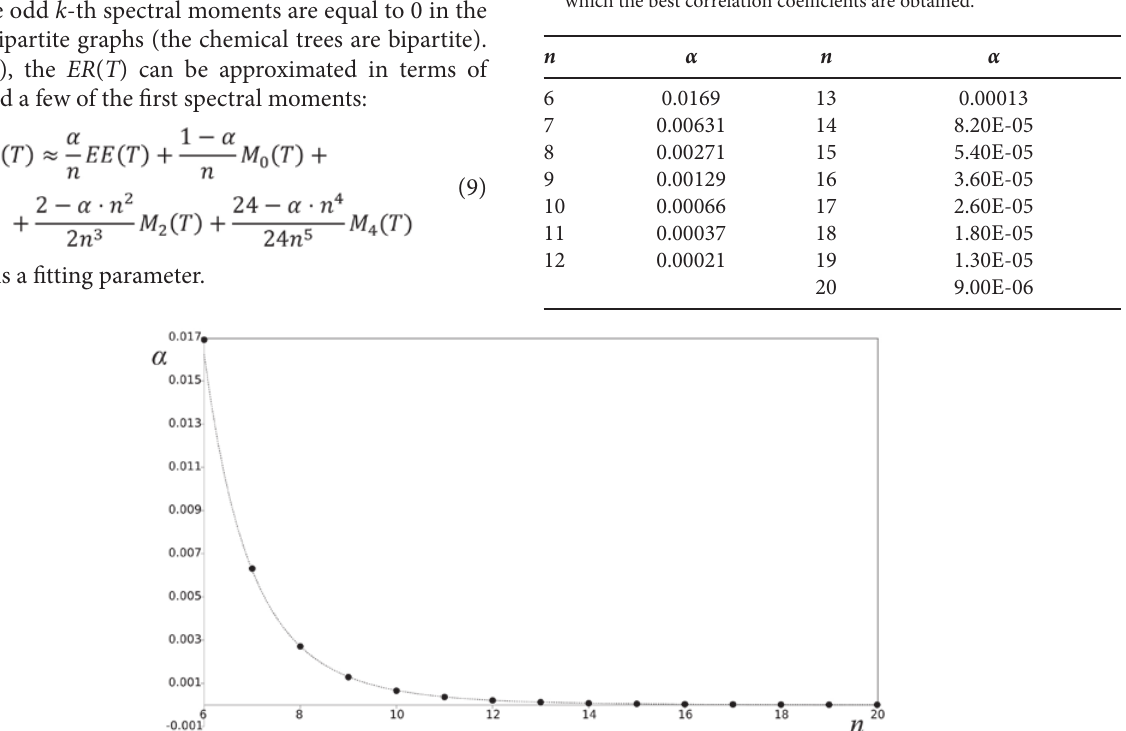
Figure 4. The relation between the fitting parameter α and the number of vertices in chemical Redžepović and Boris Furtula: On Relationships of Eigenvalue–Based Topological ...